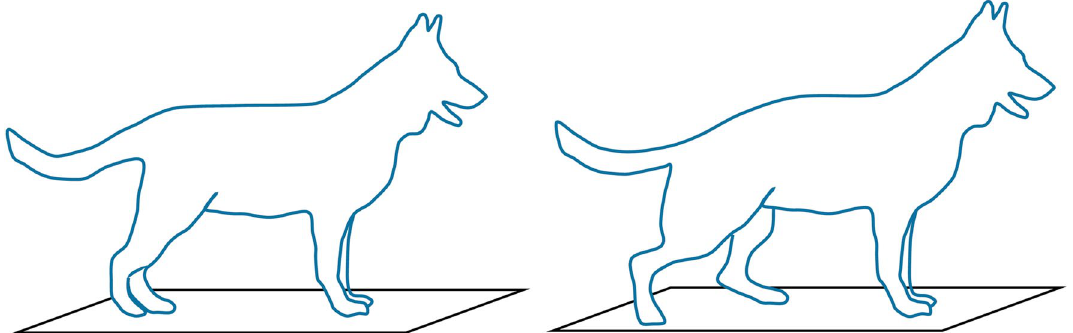
was vertical (Fig. 2, right). The stacking position is adopted in dog shows and some dogs (show dogs) were more comfortable adopting this position than square standing. Dogs trotted over the pressure walkway at a comfortable, self-selected speed for twelve valid trot stride cycles; recordings were rejected if dogs were not looking ahead, tripped or changed speed. The tracked reflective markers were assigned for each dog to create a 3D model of the dogs and these were used to compute kinematic parameters in standing and trot. The centre of each cluster on the back was used to calculate the radius of curvature of the back in the thoracic (R T ) and lumbar (R L ) regions 18 as shown in Fig. 3. Thus, dogs with a more arched back profile would have a smaller radius of curvature. Marker positions were also used to describe the angulation of joints (flexion/extension, abduction/adduction and internal/external rotation) and limb positioning. The flexion/extension and abduction/adduction angles of